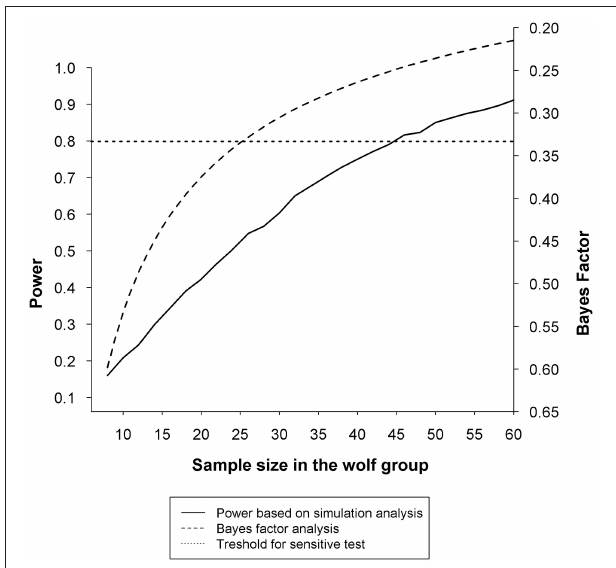
FIGURE 1 | Statistical sensitivity relative to sample size when testing the association between oxytocin change in owners and duration of animal-to-owner gaze. The solid line represents the statistical power based on 10,000 simulated samples at each sample size of the wolf group between 8 and 60. Simulated samples were generated to match the observed correlation reported by Nagasawa et al. (2015) ( r = 0.53) in the dog group and the theoretical correlation of r = 0 in the wolf group. Results show that 44 wolves (and the same number of dogs) would be necessary to show significant difference in the association between oxytocin change in owners and duration of animal-to-owner gaze in at least 80% of the samples ( power = 0.8). The dashed line represents the Bayes Factor at each sample size between 8 and 60 calculated with a half-normal prior based on the observed correlation ( r = 0.53) in the dog group and the theoretical correlation of r = 0 in the wolf group. A Bayes factor on the r = 0 for wolves indicates that due to the low sample size, the data are insensitive and do not provide evidence for the null hypothesis [ B H(0 , Fisher ’ s z(0.60)) = 0.51; see (Dienes, 2014)], and that at least 26 wolves would be required for a sensitive test [ B H(0 , Fisher’s z(0.60)) = 0.33] to provide evidence against correlation between oxytocin change in owners and duration of animal-to-owner gaze. The dotted line marks the thresholds for statistical sensitivity regularly used in the literature: power = 0.8 and B =